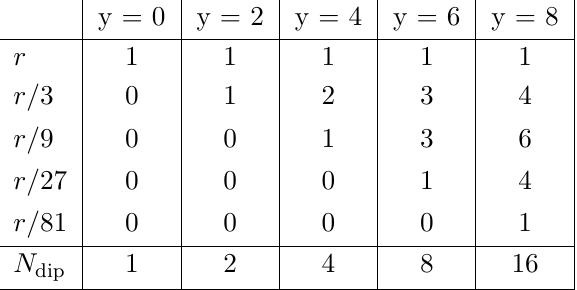
(cid:0) n (cid:1) . k